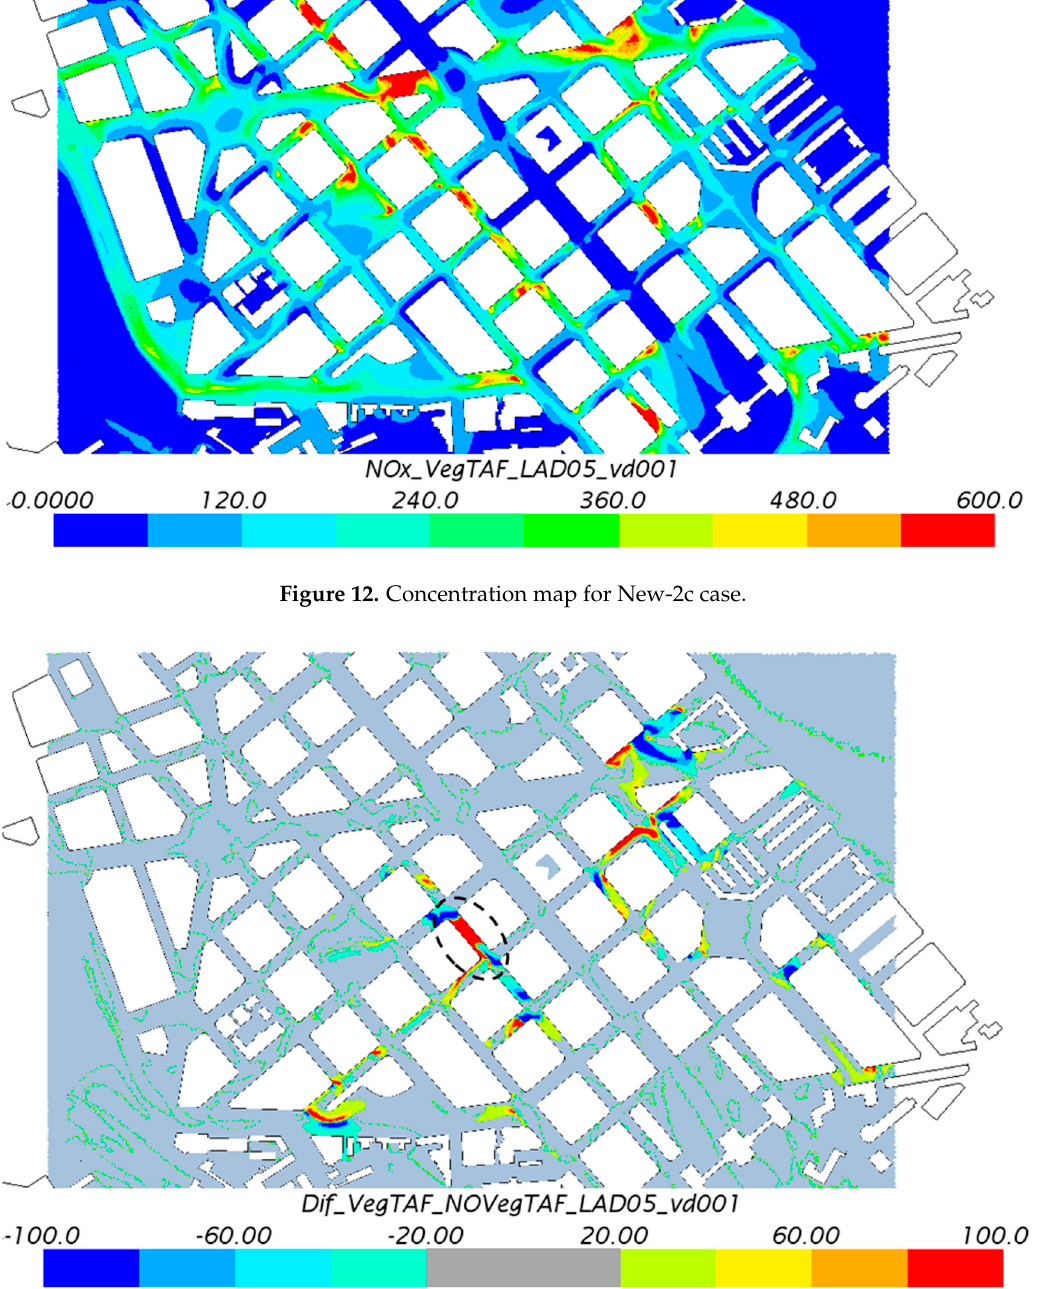
Figure 13. Differences of concentration comparing Current-2c case with New-2c case. Red indicates that the concentration increases in the new vegetation scenario and grey indicates the zone where the differences are lower than 20 µg m − 3 .